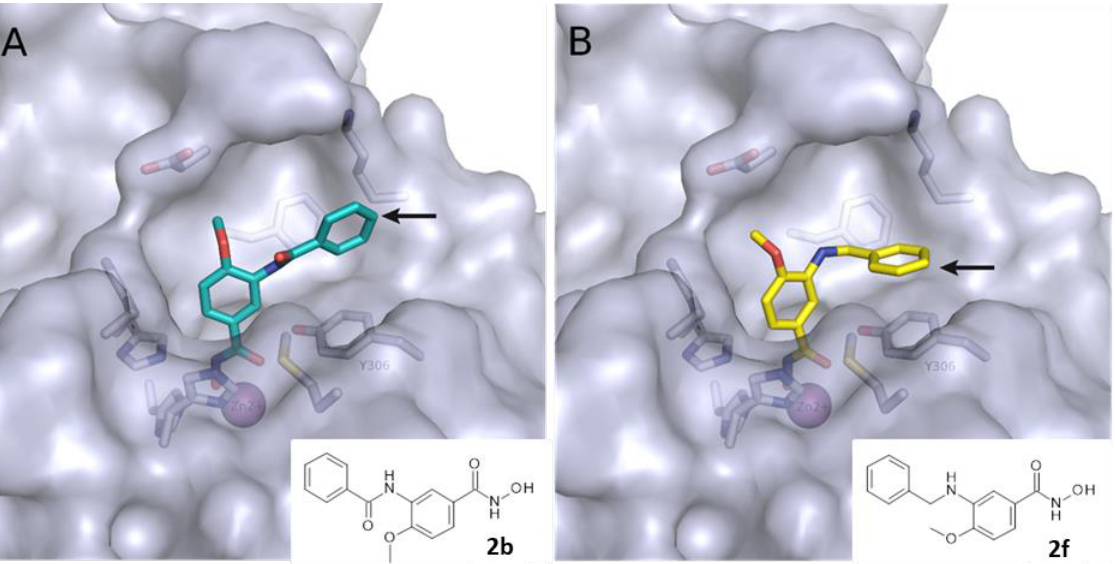
Figure 3. Predicted binding mode of ( A ) 2b (colored cyan) and ( B ) 2f (colored yellow) in human HDAC8 (PDB ID: 6ODB). The arrow indicates the point of linker attachment (p-position of the terminal phenyl ring).